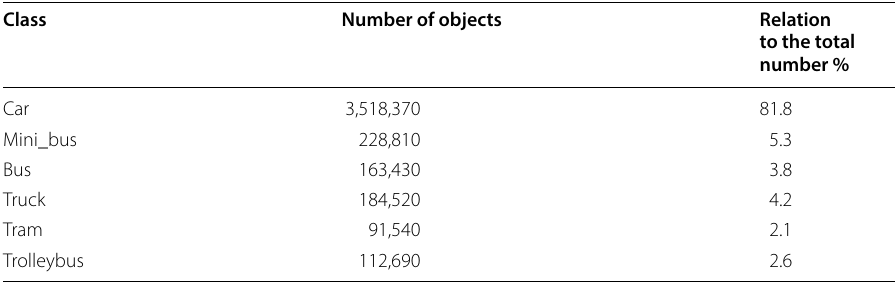
Table 2 Distribution of vehicle classes in the training